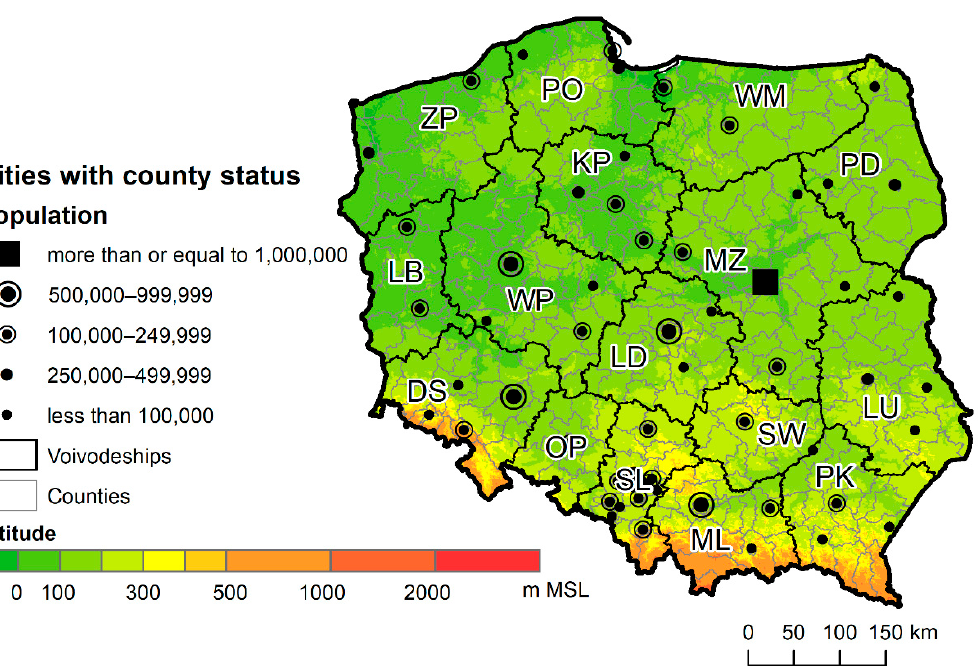
Figure 1. Topographic map of Poland, with the main cities and Voivodeships. Voivodeship names: DS—Lower Silesia, KP—Kuyavian-Pomeranian, LU—Lublin, LB—Lubusz, LD—Lodz, MZ—Masovian, ML—Lesser Poland, OP—Opole, PD—Podlaskie, PK—Subcarpathian, PO—Pomeranian, SL—Silesian, SW—Swietokrzyskie, WM—Warmian-Masurian, WP—Greater Poland, ZP—Western Pomeranian.